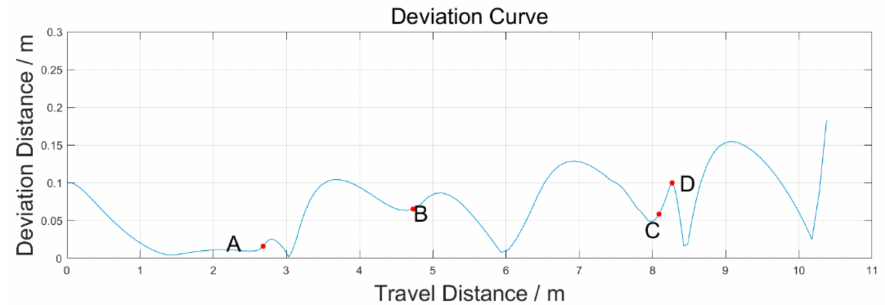
Figure 17. Deviation distance between the actual path and the reference